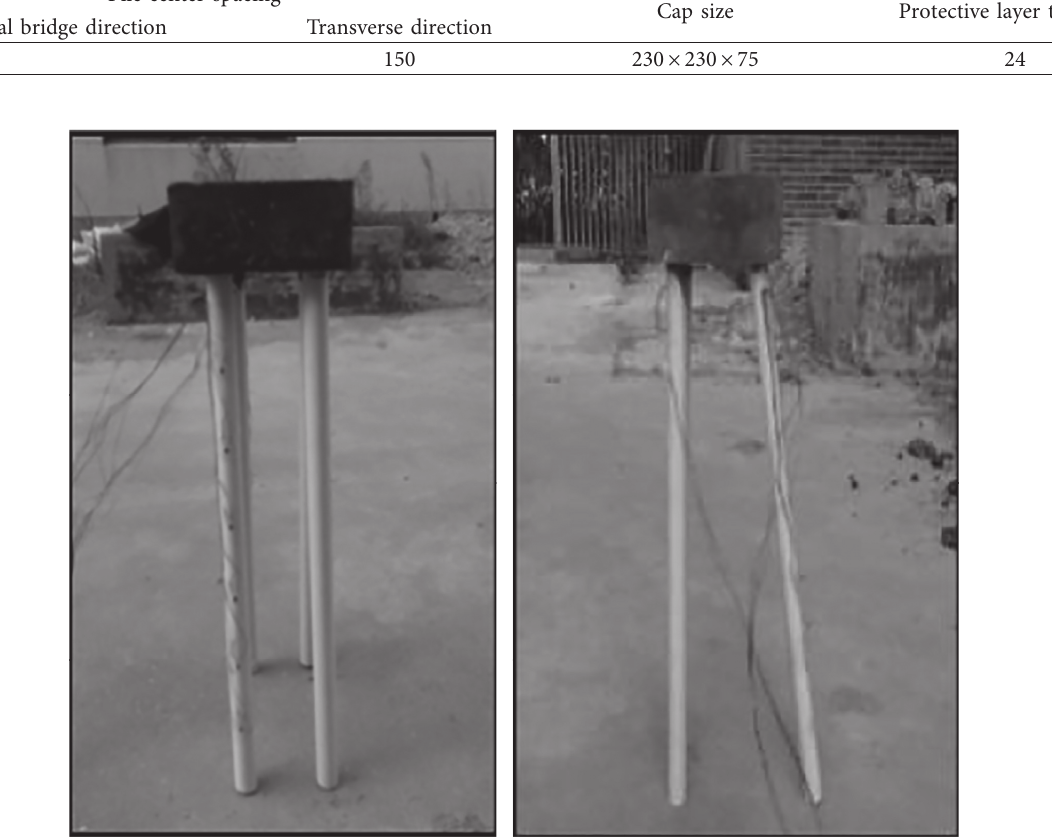
Figure 2: Model of inclined and straight alternating pile